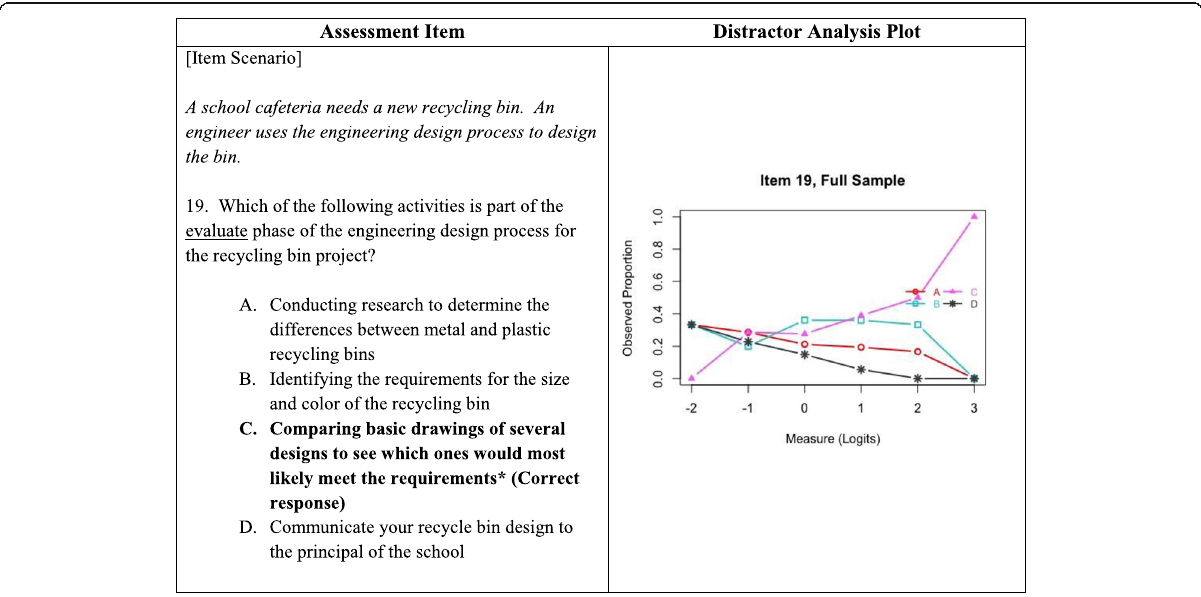
Fig. 6 Distractor analysis plot for item 19: full sample. The plot shows patterns of student answer choices for item 16 within the entire sample. The x -axis displays estimates of student achievement. Student achievement estimates are shown in logits, and these estimates were calculated using the Rasch model. Low values indicate lower achievement, and high values indicate higher achievement. The y -axis shows the observed proportion of responses for a given answer choice. The lines in the plot show the proportion of students who selected each of the four answer choices (A, B, C, or D) at each level of achievement. For this item, the correct response is C (pink line with triangle plotting